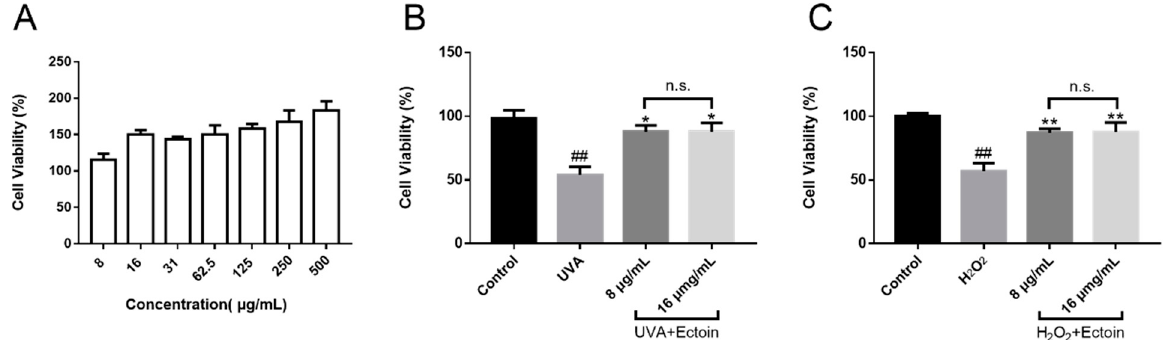
Figure 2. The toxicity of Ectoin ( A ) to HSF cells and the repair effects of Ectoin on UVA-induced ( B ) and H 2 O 2 -induced ( C ) oxidative stress damage in HSF cells. The results are expressed as mean ± SD (n = 3). The model in ( B ) was established by UVA (22 J/cm 2 ), and the model in ( C ) was established by H 2 O 2 (1000 µ mol · L − 1 ). The discussed concentrations of Ectoin are 8 and 16 µ g/mL. Statistical significance was determined by ANOVA test. (## p < 0.01, compared with the DMEM-treated control. * p < 0.05, and ** p < 0.01, compared with the Model. n.s., p > 0.05).